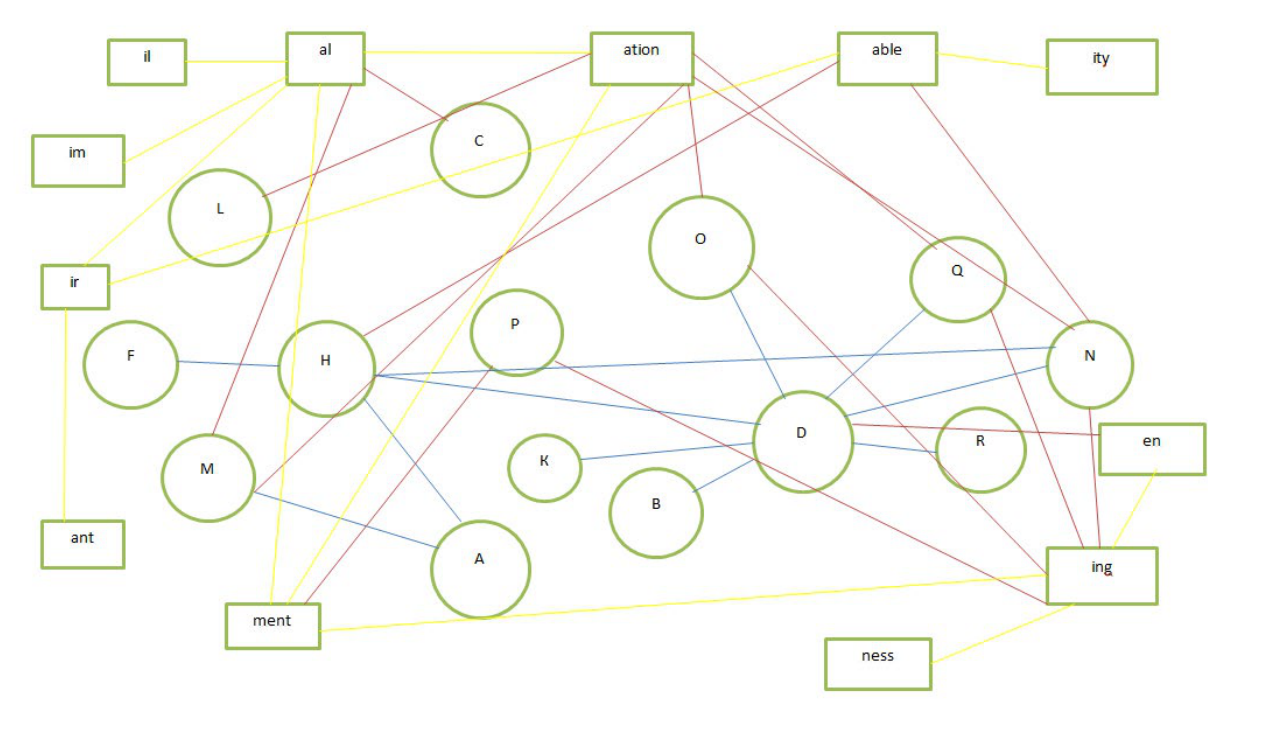
Figure 2 – compatibility of semantic